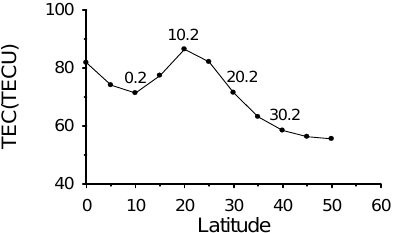
Fig. 5. The geographical latitudinal distribution (from 0 ◦ N to 50 ◦ N) of TEC along the 120 ◦ meridional line calculated from IRI model (IRI model parameters: longitude: 120 ◦ E; day of year: 280; local time: 12LT; R12: 150; height range selection: 100–1000km; height step: 1km). The values labeled in the figure are the corre- sponding geomagnetic